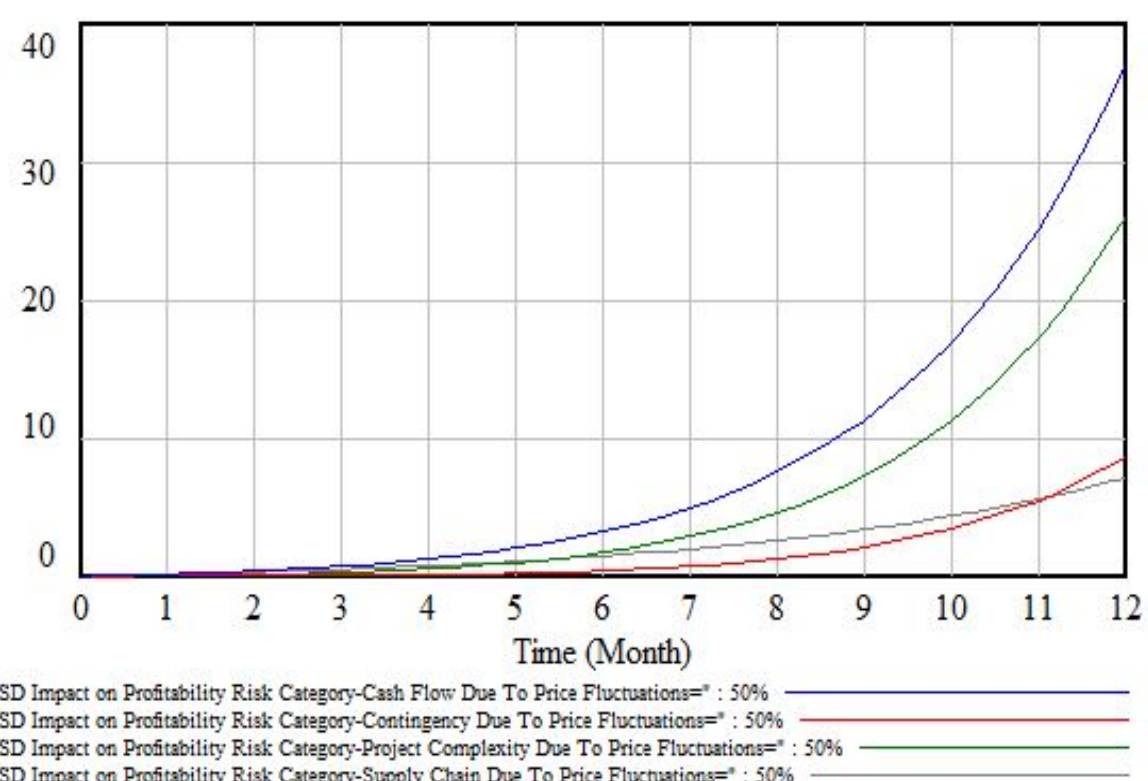
Figure 10. Dynamic integrated impacts on profitability risk categories over time (price fluctuations = 10%).